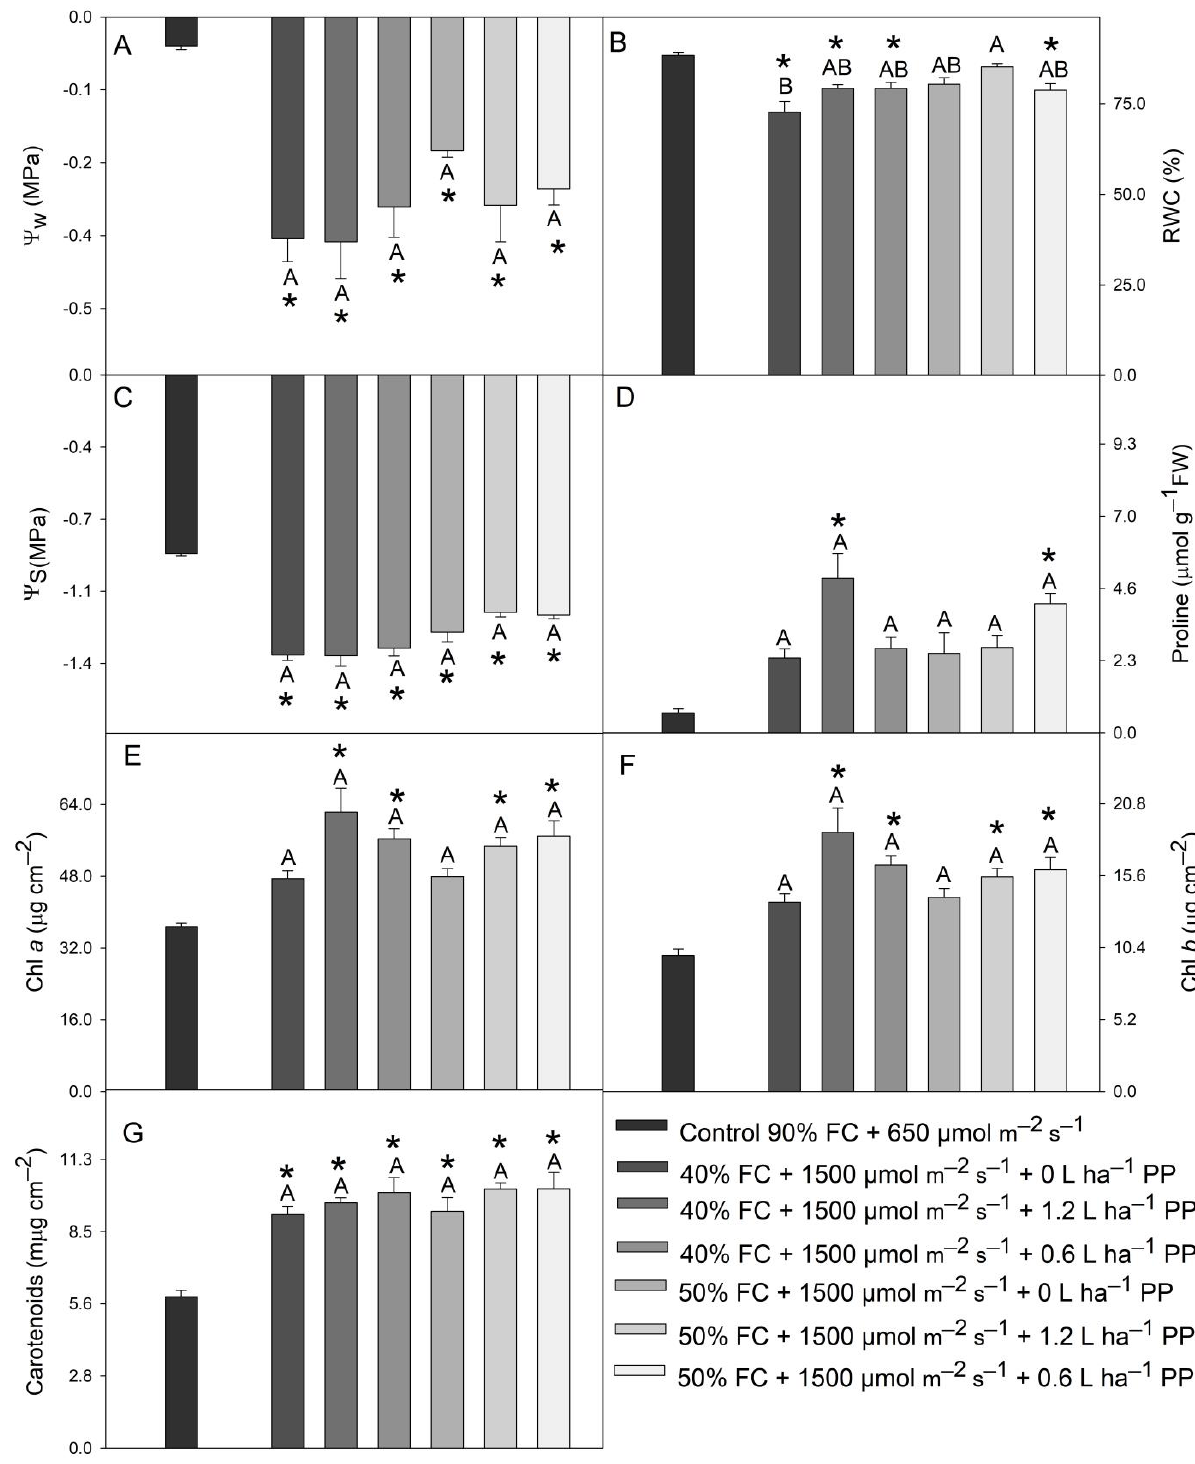
Figure 1. Leaf water potential ( Ψ w ; ( A )), relative leaf water content (RWC; ( B )), leaf osmotic potential ( Ψ s ; ( C )), concentrations of proline ( D )), chlorophyll a (Chl a € ; ( E )), chlorophyll b (Chl b ; ( F )) and carotenoids ( G ) of soybean plants treated with doses of potassium phosphite (PP) and exposed to water deficit + high irradiance for 12 days. Bars represent mean ± SEM ( n = 5). Means followed by an asterisk (*) differ from control by Dunnett’s test ( p < 0.05). Means followed by the same letter did not differ among stress treatments, as determined by Tukey’s test ( p <